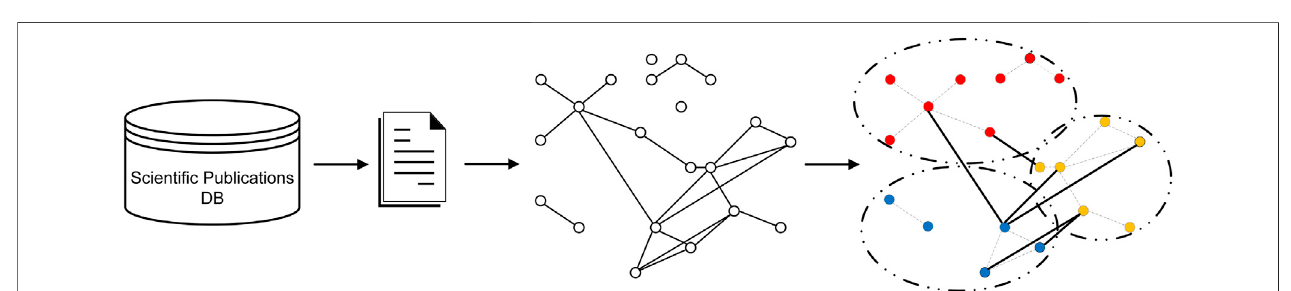
FIGURE 2 | Schematic illustration of the co-occurrence associations in a heterogeneous knowledge network.